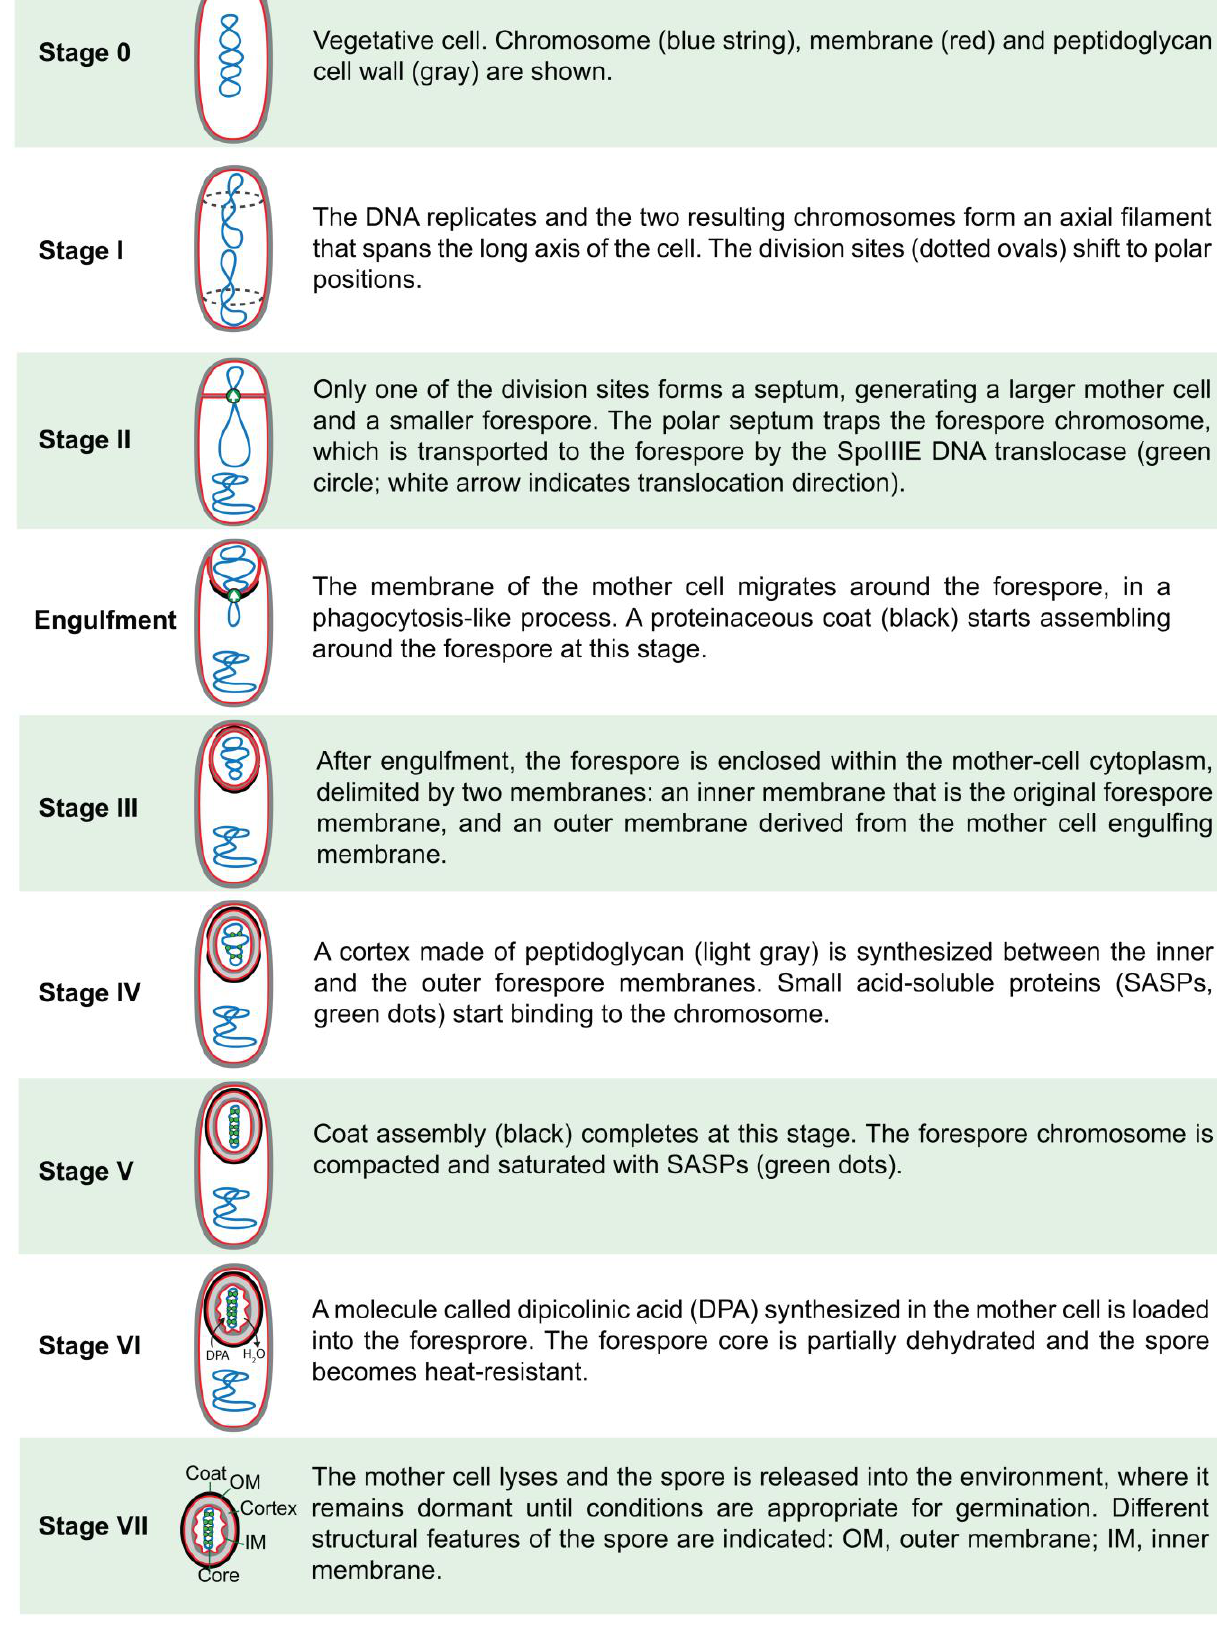
FIGURE 2: Sporulation stages in B. subtilis